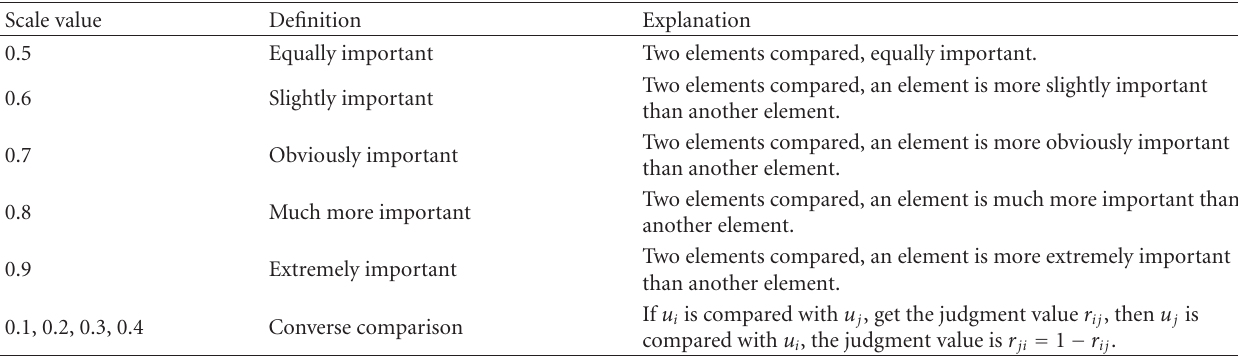
Table 1: The quantity scale of 0.1 ∼ 0.9.